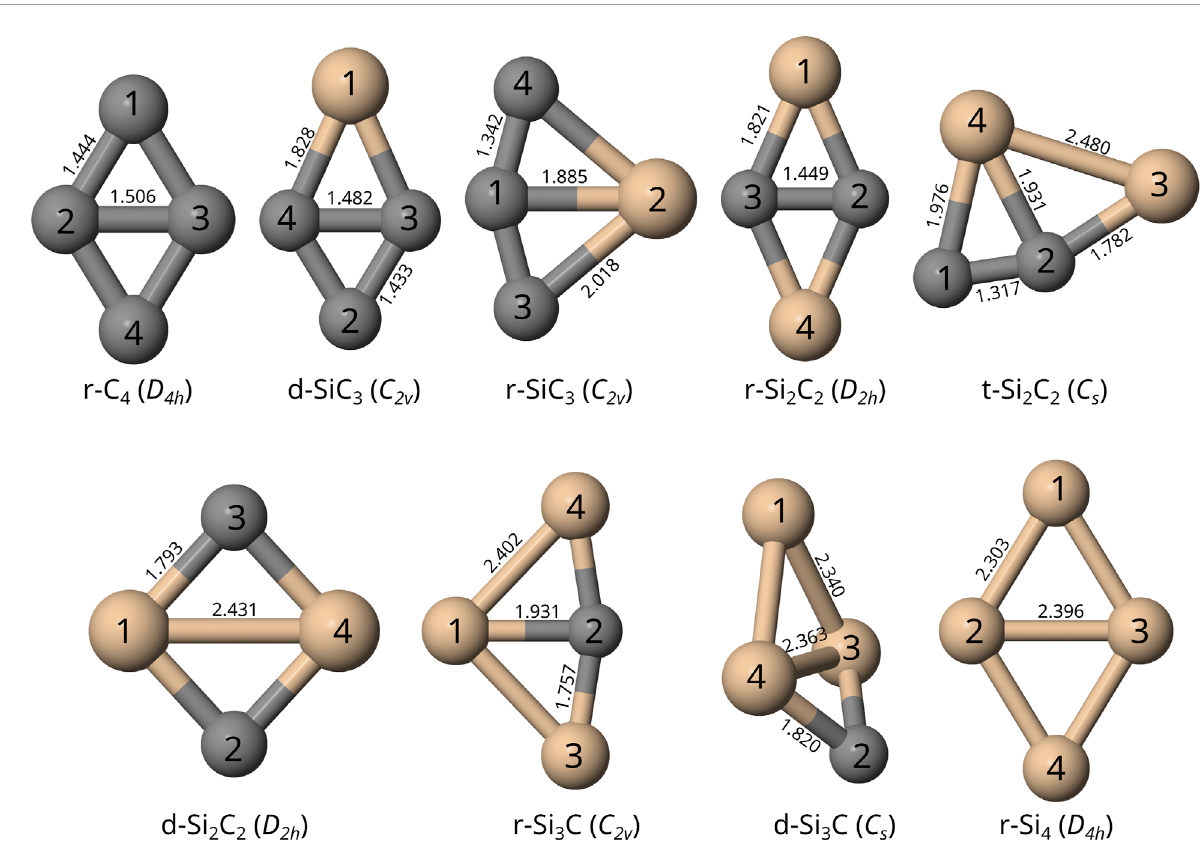
FIGURE 1 Visual depiction of the optimized structures for each TASCC with atomic labels, including molecular bond lengths reported in Å, computed at the F12-TZ-cCR level of theory. Silicon is shown in tan and carbon is shown in gray. These are ordered as (top row, from left) r -C 4 , d -SiC 3 , r -SiC 3